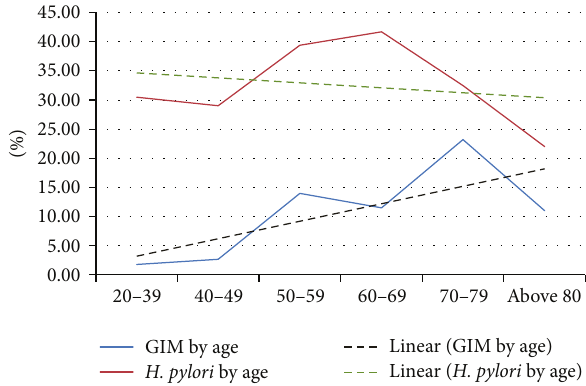
Figure 1: Trend of gastric intestinal metaplasia and active Helicobac- ter pylori with age.